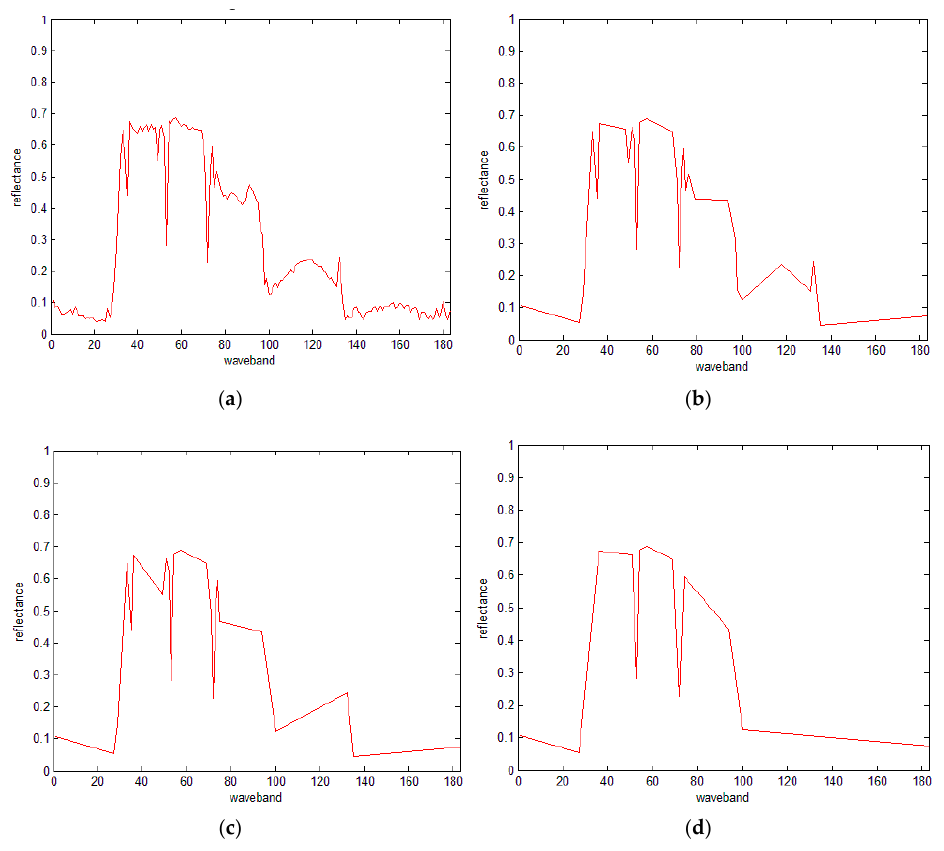
Figure 3. The simplified spectral curve using the DP algorithm with different thresholds. ( a ) The original spectral curve with 183 points, ( b ) D = 0.05, 30 retained points, ( c ) D = 0.1, 23 retained points, and ( d ) D = 0.2, 13 retained points.